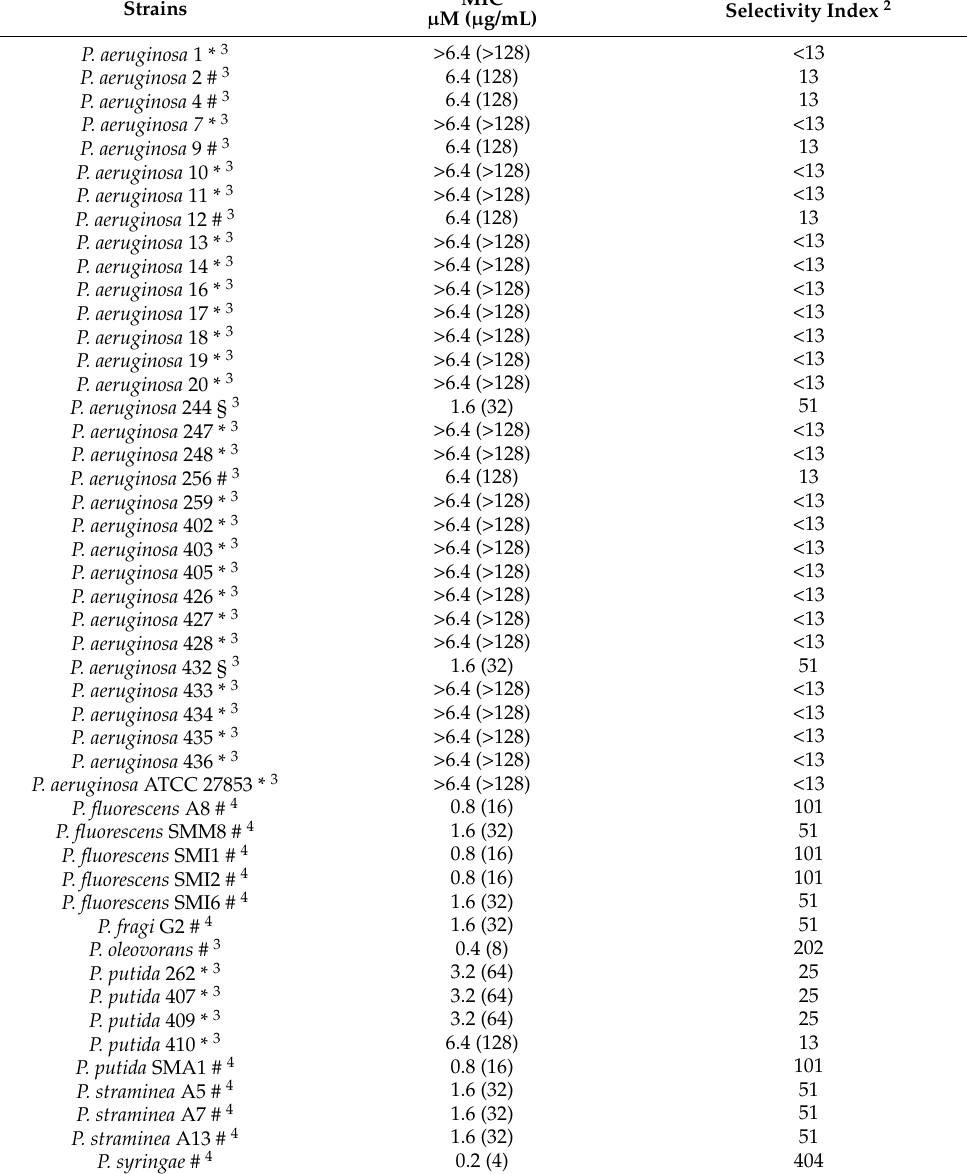
Table 4. MIC values of G5-PDK obtained on clinical and environmental isolates of Pseudomonas genus from experiments conducted in triplicate 1 (expressed as µ M and as µ g/mL), and the selectivity indices (SIs) of G5-PDK for each strain determined using the LD 50 of G5PDK obtained from the cytotoxicity